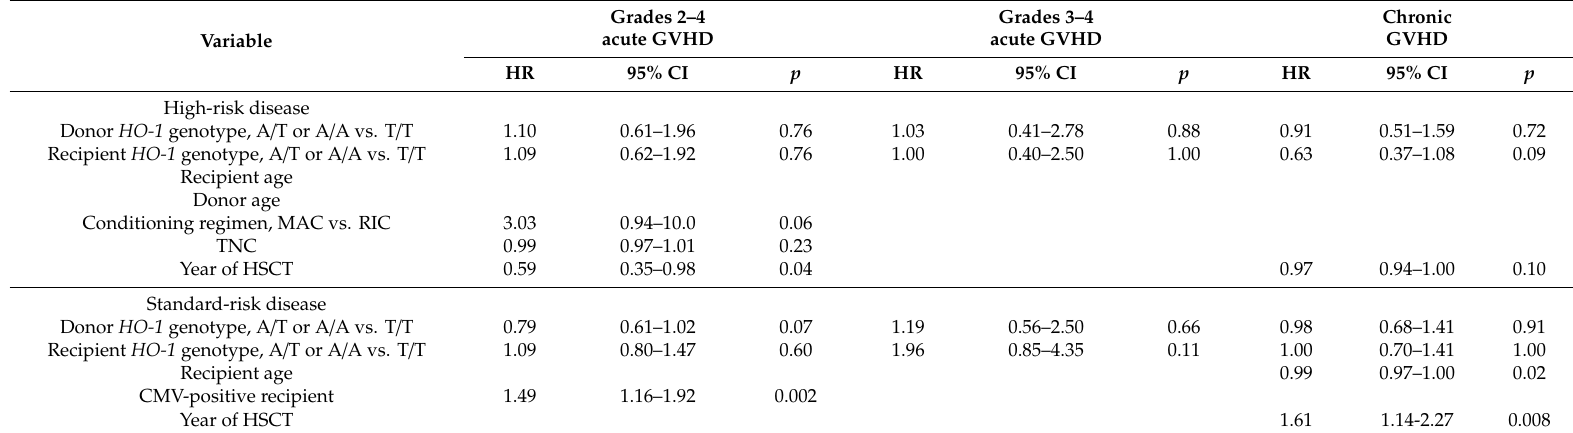
Table 3. The results of the multivariate analysis of the association between the HO-1 genotype and the clinical outcomes after transplantation (second part).